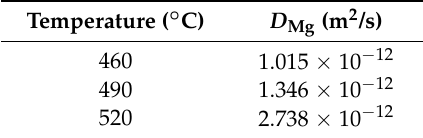
Table 4. Diffusion coefficient of Mg at the original interface under different bonding